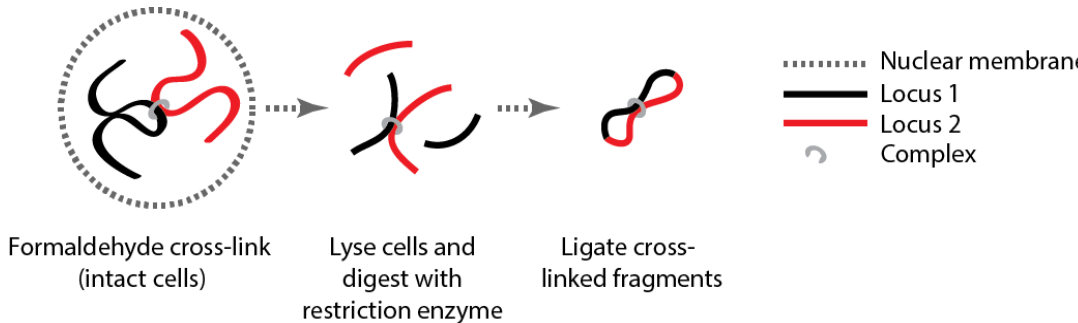
Figure 1. The key steps in proximity